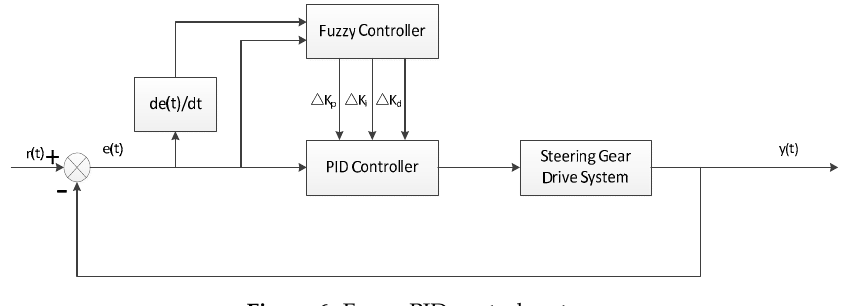
Figure 6. Fuzzy PID control system.